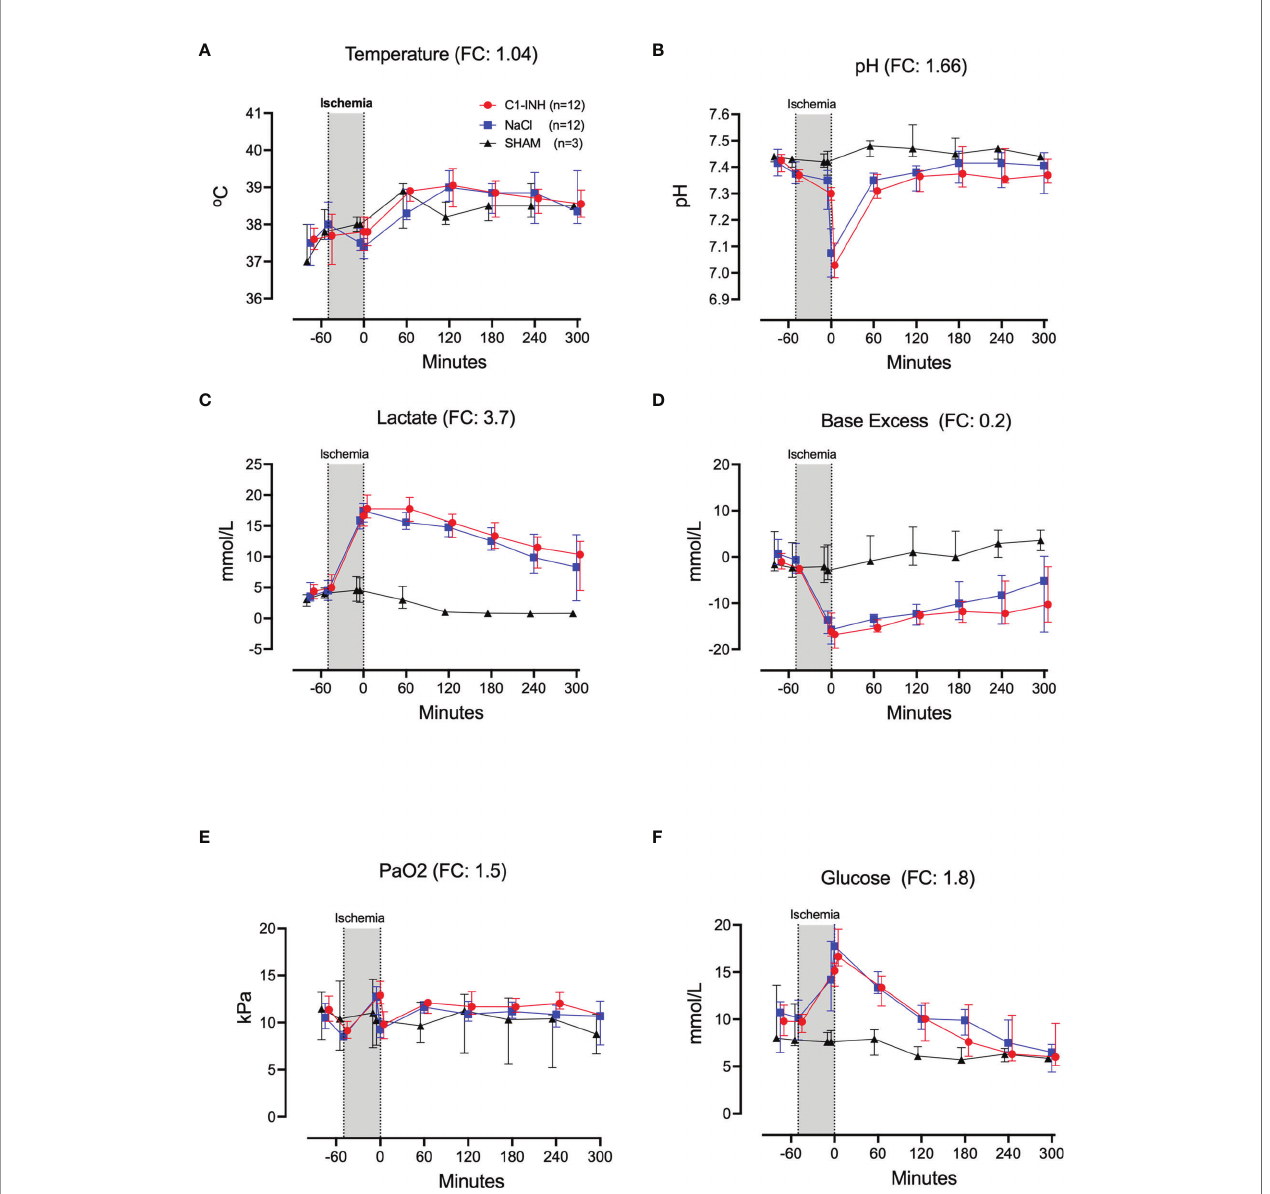
FIGURE 2 | Cardiorespiratory response II. (A) Temperature, (B) pH, (C) lactate, (D) Base Excess, (E) PaO2, and (F) Glucose were measured in 24 piglets undergoing 45 minutes of clamping of the thoracic aorta at the Th8 level. FC for Ph was calculated with absolute numbers of hydrogen ions. Upfront 12 piglets received human saline intravenously and 12 received C1-INH (250 IU/kg), respectively. Three sham animals received thoracic opening without clamping. Reperfusion started at 0 minutes and lasted 5 hours. Longitudinal time data are expressed as median and interquartile range. “ Ischemia ” indicates the 45 minutes period of clamping. NaCl and C1-INH-groups were combined when there were no differences in the fold change (FC) calculation. FC is the change from before cross-clamp onset to maximum